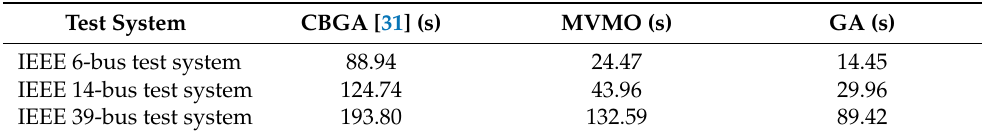
Table 14. Average processing times for all the IEEE test systems considering different optimization